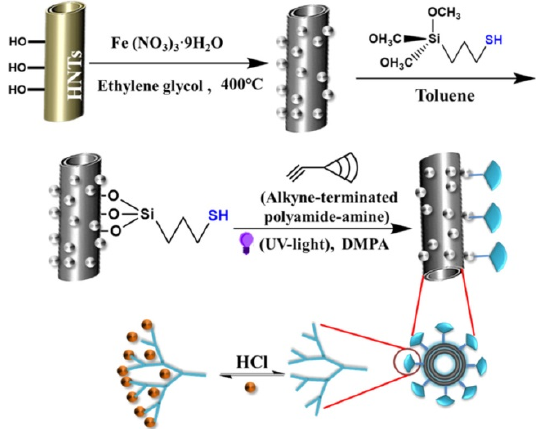
Figure 17. Schematic diagram showing the synthetic route of PAMAM grafted magnetic halloysite and removal of Pb(II) from water. Reproduced with permission from [147].